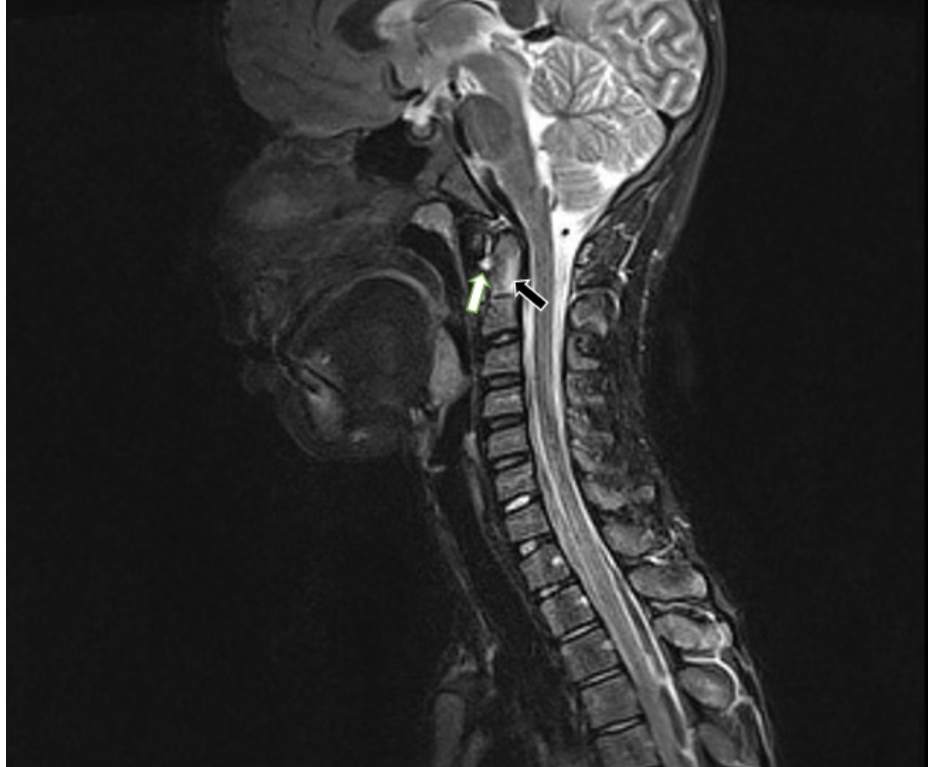
Figure 2. Sagittal MRI, TIRM T2w sequence in a 12-year-old boy diagnosed with enthesitis-related arthritis shows BME in the dens (black arrow) and atlantoaxial effusion (white arrow). MRI—magnetic resonance imaging, TIRM T2w-turbo inversion recovery magnitude T2 weighted, BME—bone marrow edema.